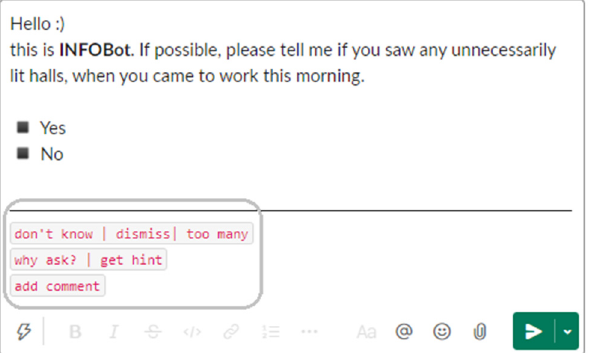
Figure 8. Possible rendering of a sensing request, with the full selection of generic buttons (enclosed); based on Slack [10].